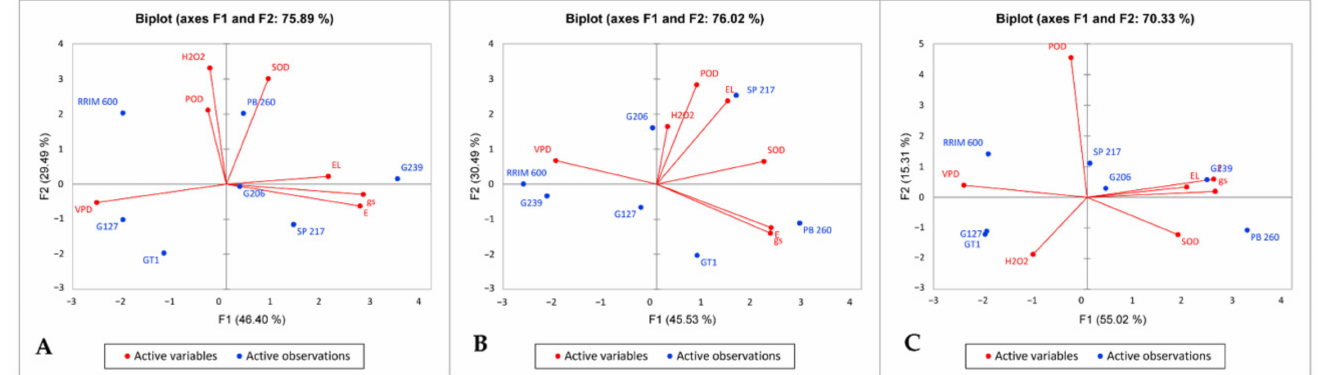
Figure 2. The results of the biplot analysis of all observed variables and rubber clones under three dif- ferent water deficit conditions, namely: normal condition ( A ), severe water deficit condition ( B ), and re- covery condition ( C ). Note: gs —stomatal conductance (mol H 2 O m − 2 s − 1 ), E —transpiration rate (mmol H 2 O m − 2 s − 1 ), VPD—vapor pressure deficit (kPa), EL—electrolyte leakage (%), H 2 O 2—